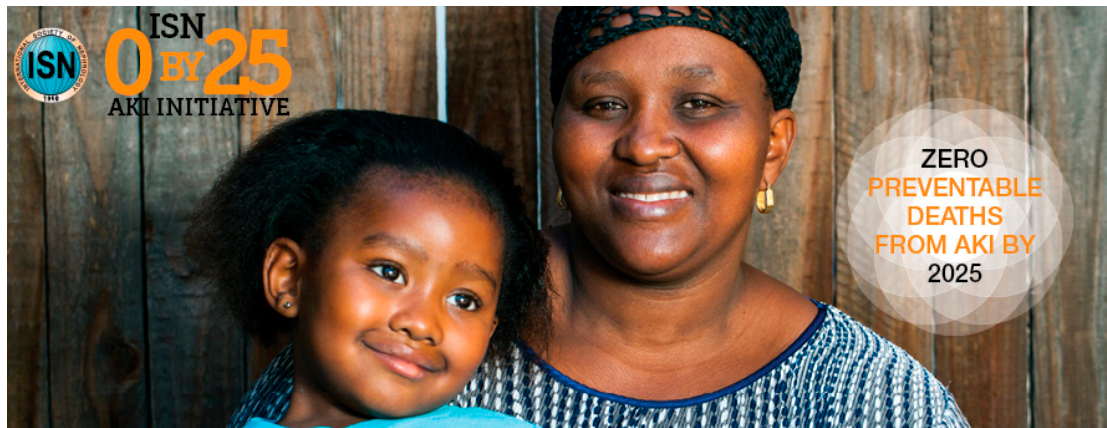
Figure 1. One of the icons of the “O by 25” campaign of the International Society of Nephrology; Available online: https://www.theisn.org/all-articles/616-0by25 (accessed on 25 February 2019).